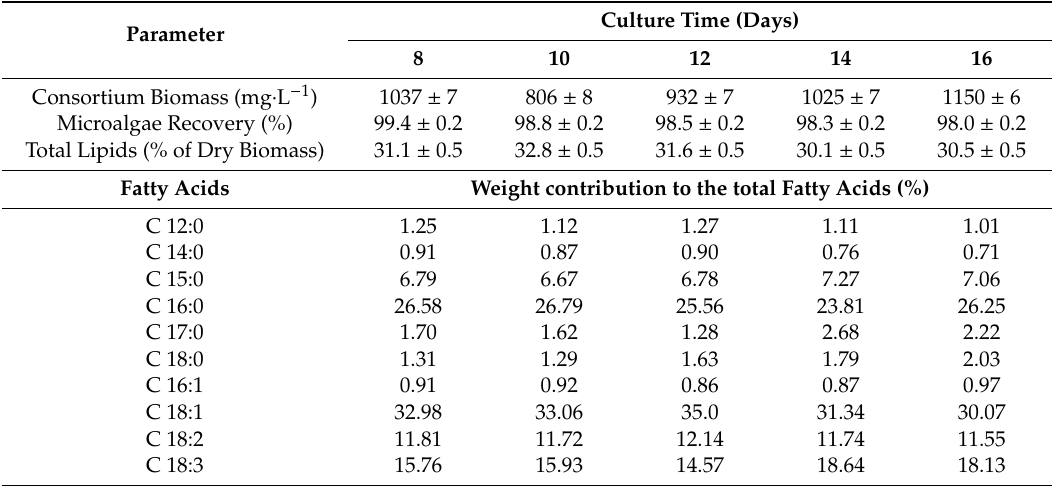
Table 2. Summary of strategy 4 lipid accumulation at di ff erent incubation